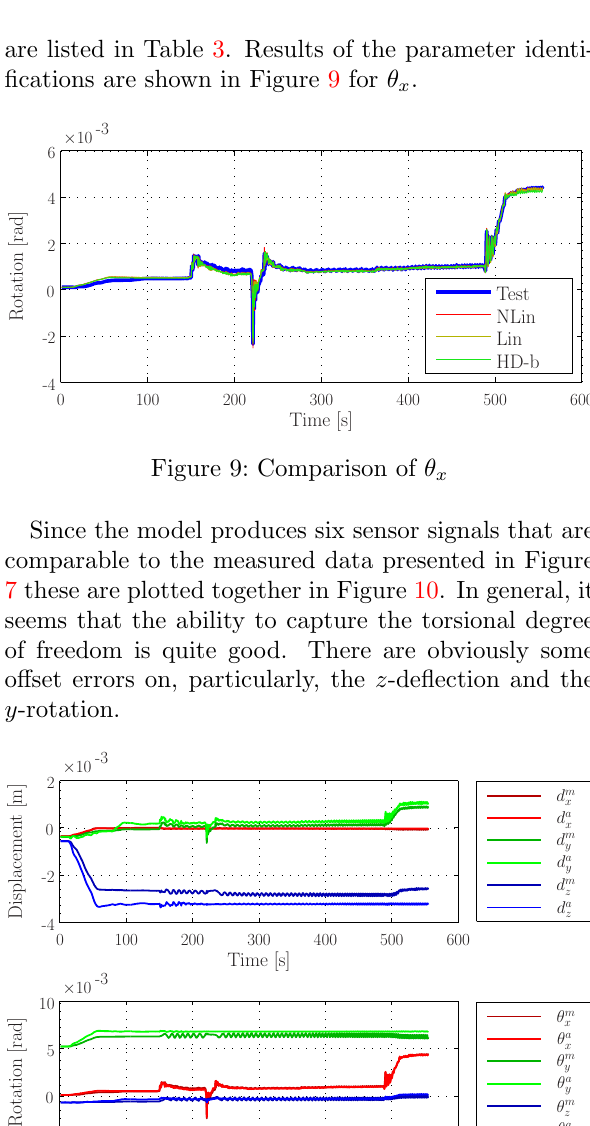
Figure 10: Comparison of results obtained with nonlin- ear bushings